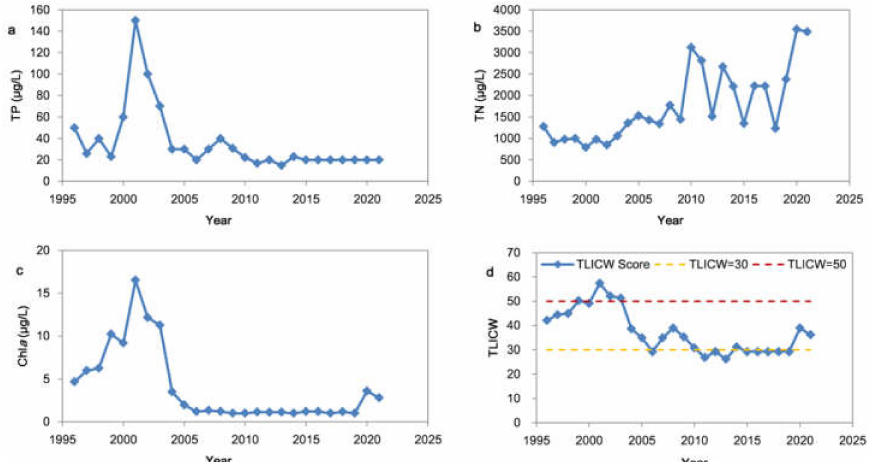
Figure 2. Interannual changes in water quality and nutrient status in the Chaihe Reservoir (1996–2021). ( a ) Total phosphours (TP) concentration; ( b ) Total nitrogen (TN) concentration; ( c ) Chlorophyll a (Chl a ) concentration; ( d ) Changed weight trophic level index (TLI CW ). The red dashed line is the boundary of oligotrophication and the mesotrophic state. The yellow dashed line is the lower limit of the eutrophication